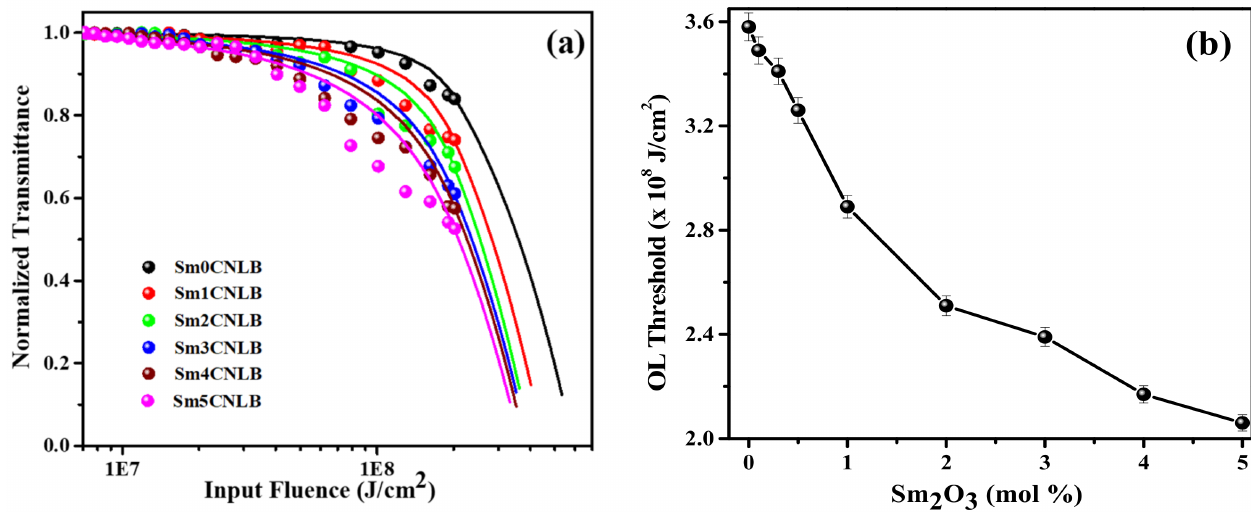
Figure 6. ( a ) OL patterns of examined Sm x CNLB glasses, where x = 0, 1, 2, 3, 4, and 5 mol %. ( b ) Variation of OL thresholds with Sm 2 O 3 content in the glass composition. The solid symbols and solid lines in ( a ) represent the measured and theoretical OL data